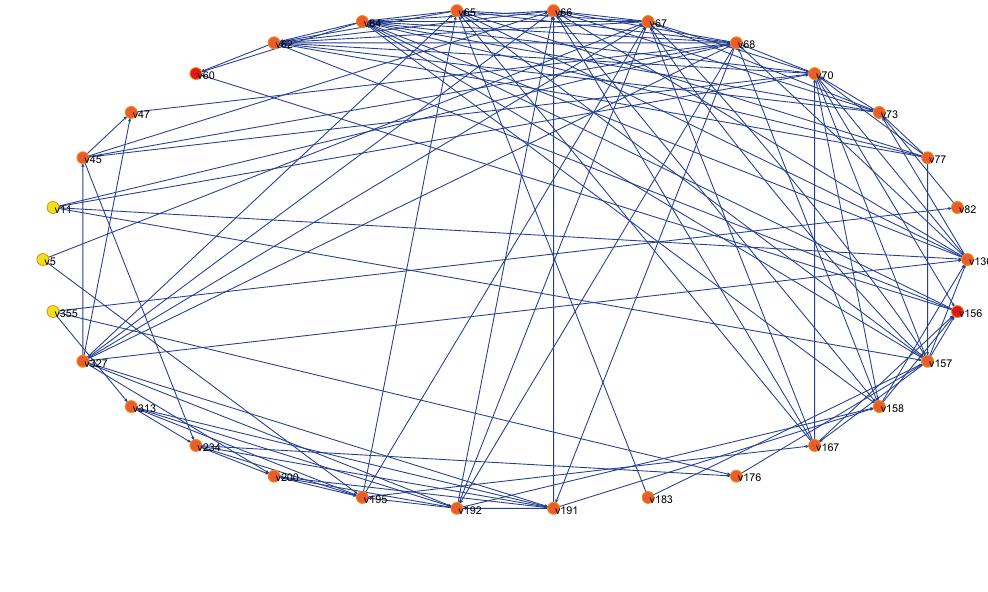
Figure 7. Key hazards and propagation paths of Dam I failure.